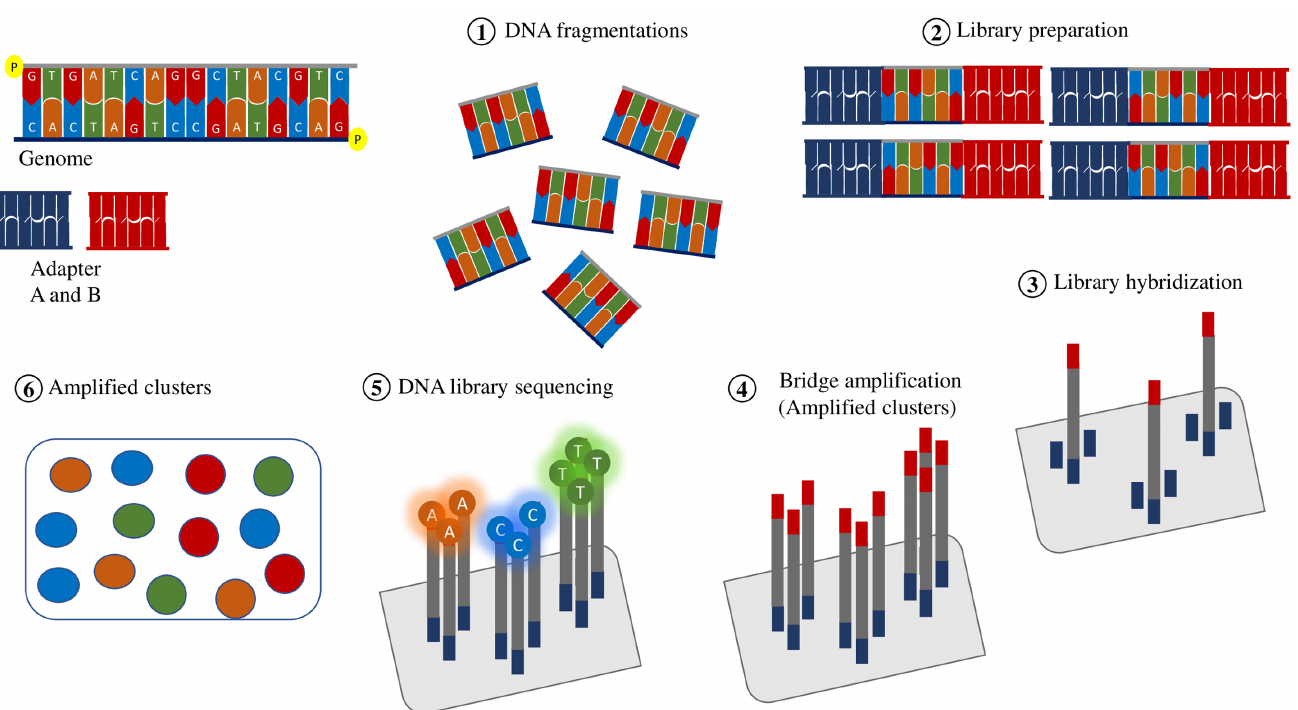
Figure 3. Library preparation and Illumina method (G: guanine, A: adenine, C: cytosine, T: